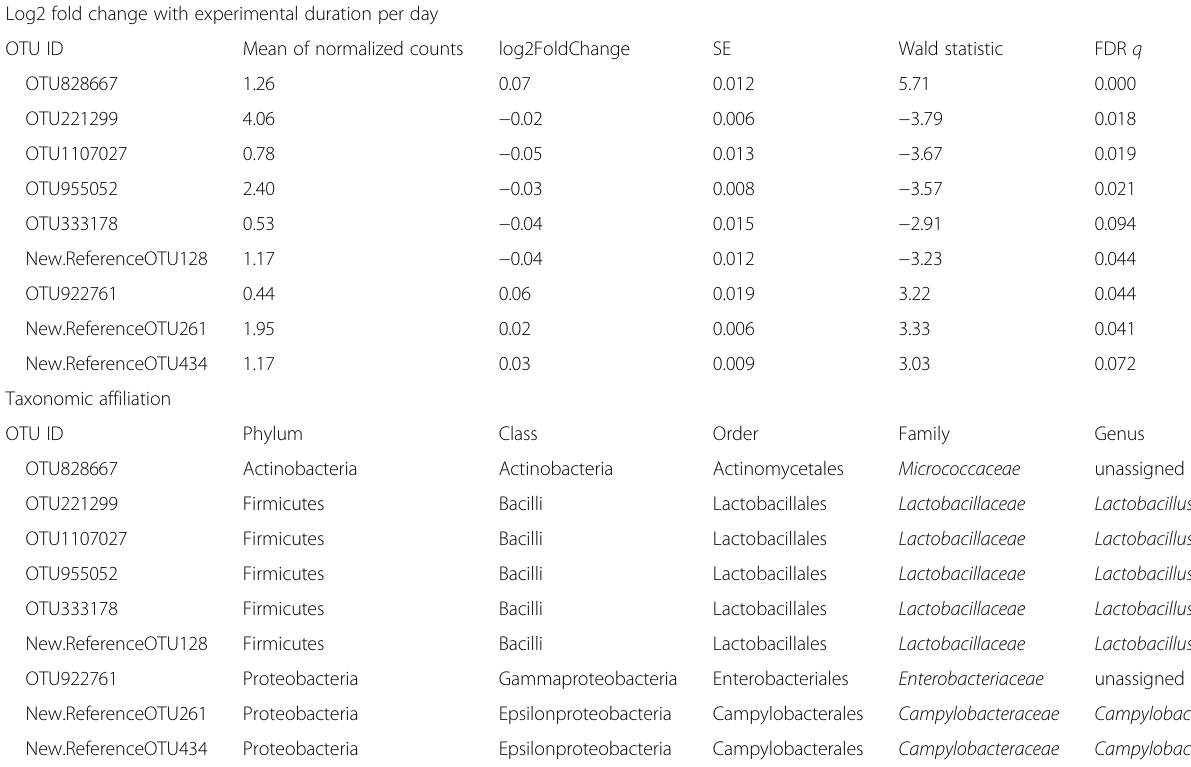
Table 5 Log2 fold change and taxonomic affiliation of temporally changing OTUs in cloacal microbiota Log2 fold change with experimental duration per day